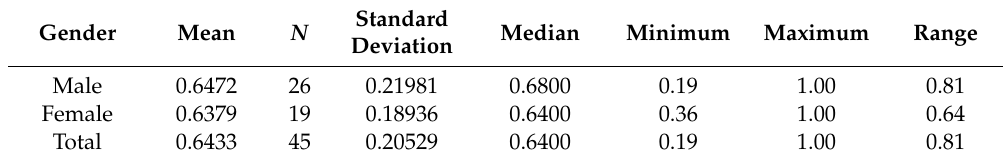
Table 17. Mean internal characteristic validity measure by gender.